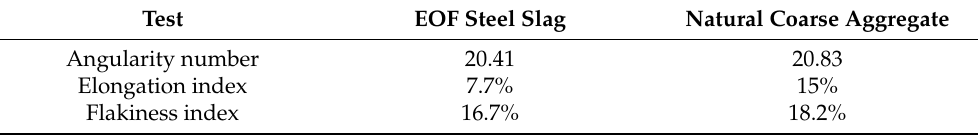
Table 2. Shape properties of natural coarse aggregate and EOF steel